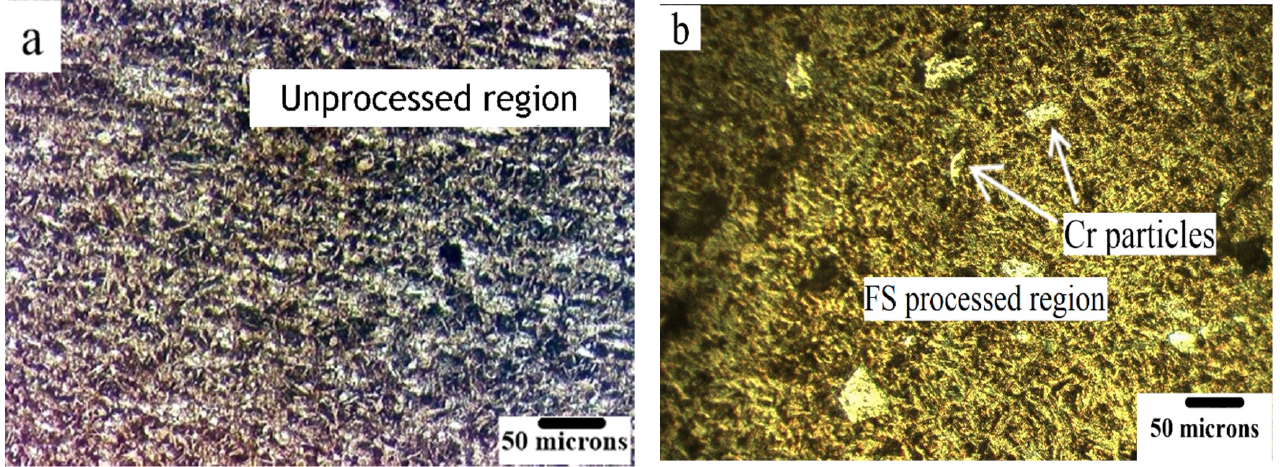
Figure 5. Optical micrographs of ( a ) the as-cast NAB and ( b ) FS-processed stir zone showing the distribution of particles.